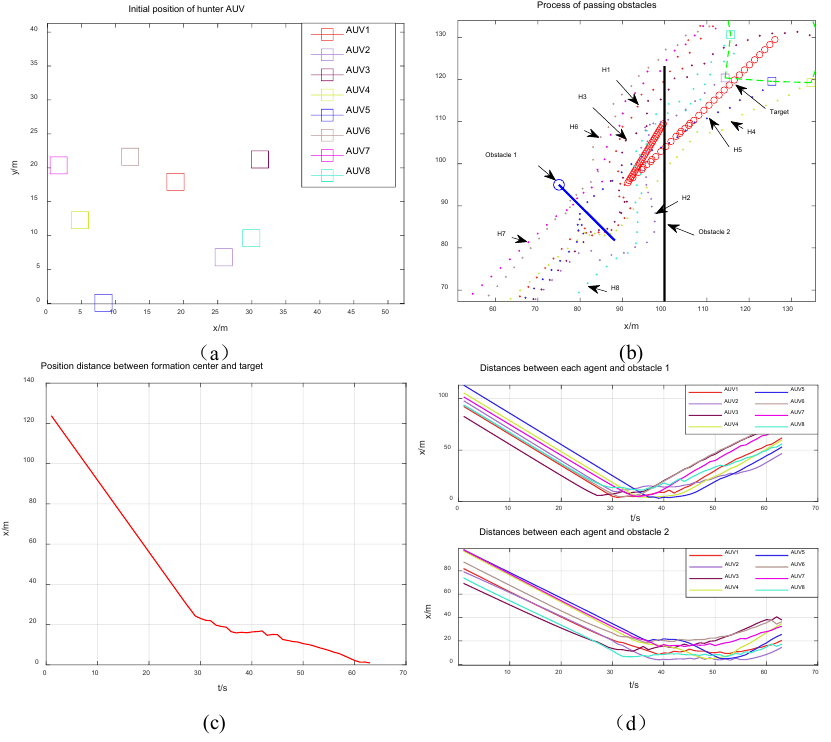
Figure 8. Cooperative hunting process based on the HAP-IAPF method in a dynamic obstacle environment.